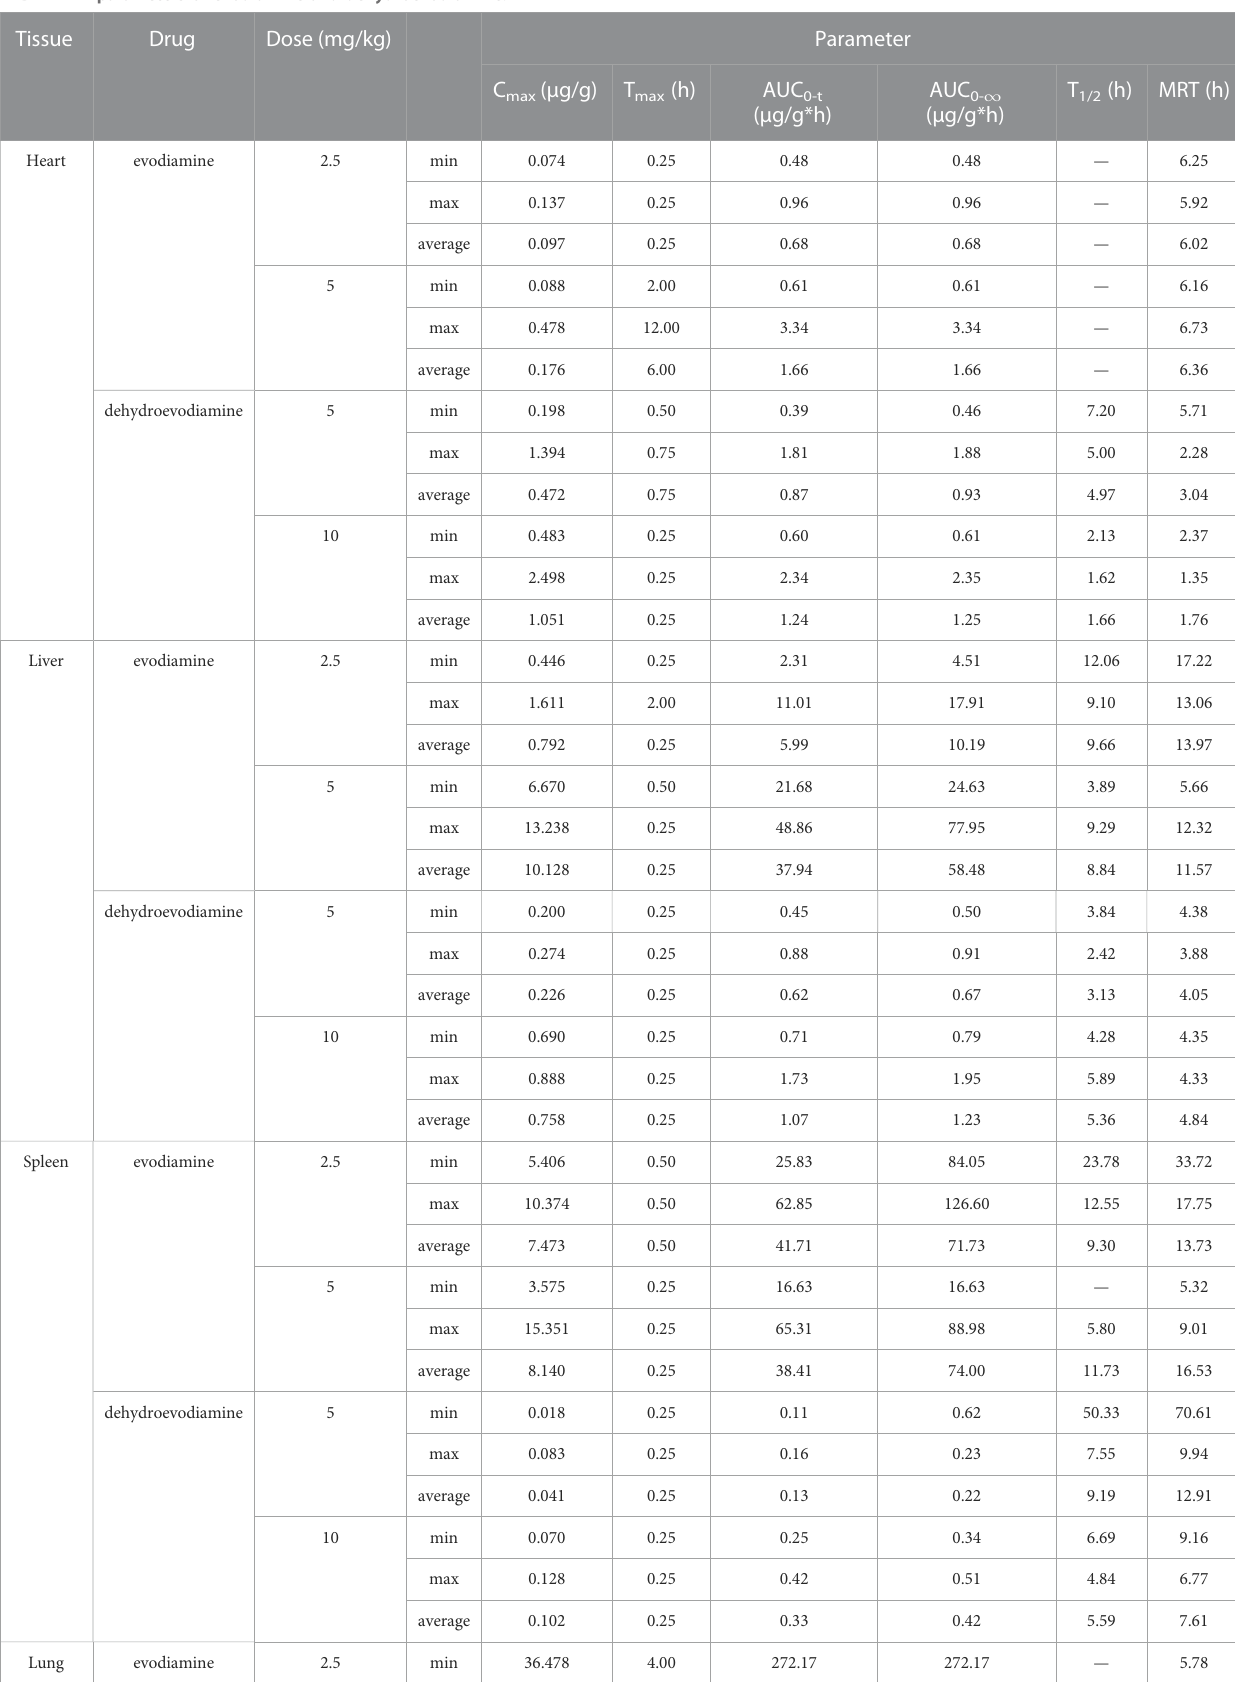
TABLE 1 PK parameters of evodiamine and dehydroevodiamine. Tissue